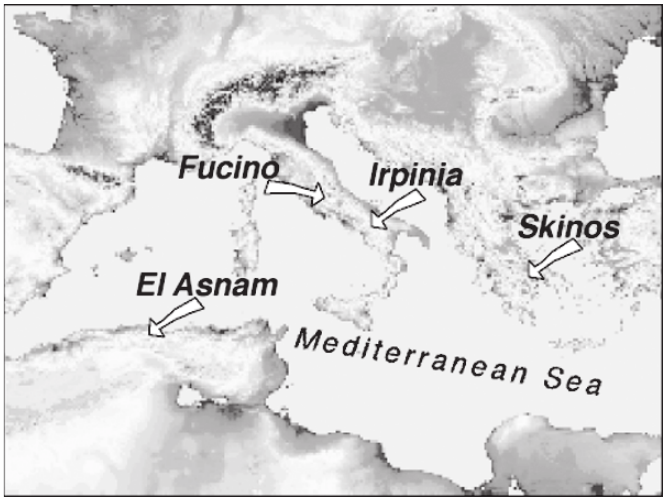
Fig. 3. Location of the four faults for which a seismic history was built on the basis of paleoseismological data extracted from the «Database of earthquake recurrence data from paleoseismology» of the